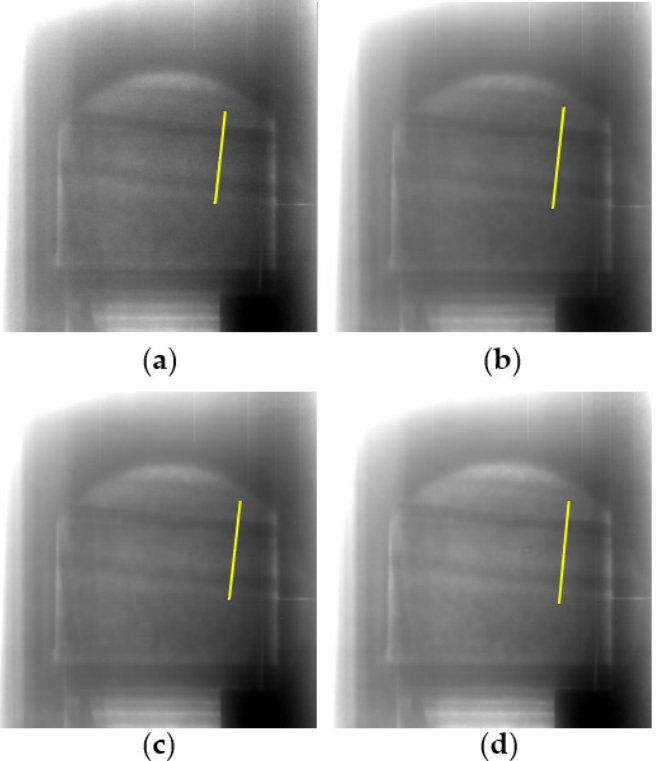
Figure 30. Measured X-ray images for 1 ( a ), 25 ( b ), 50 ( c ) and 100 shots ( d ). Gray value analysis lines are also indicated.